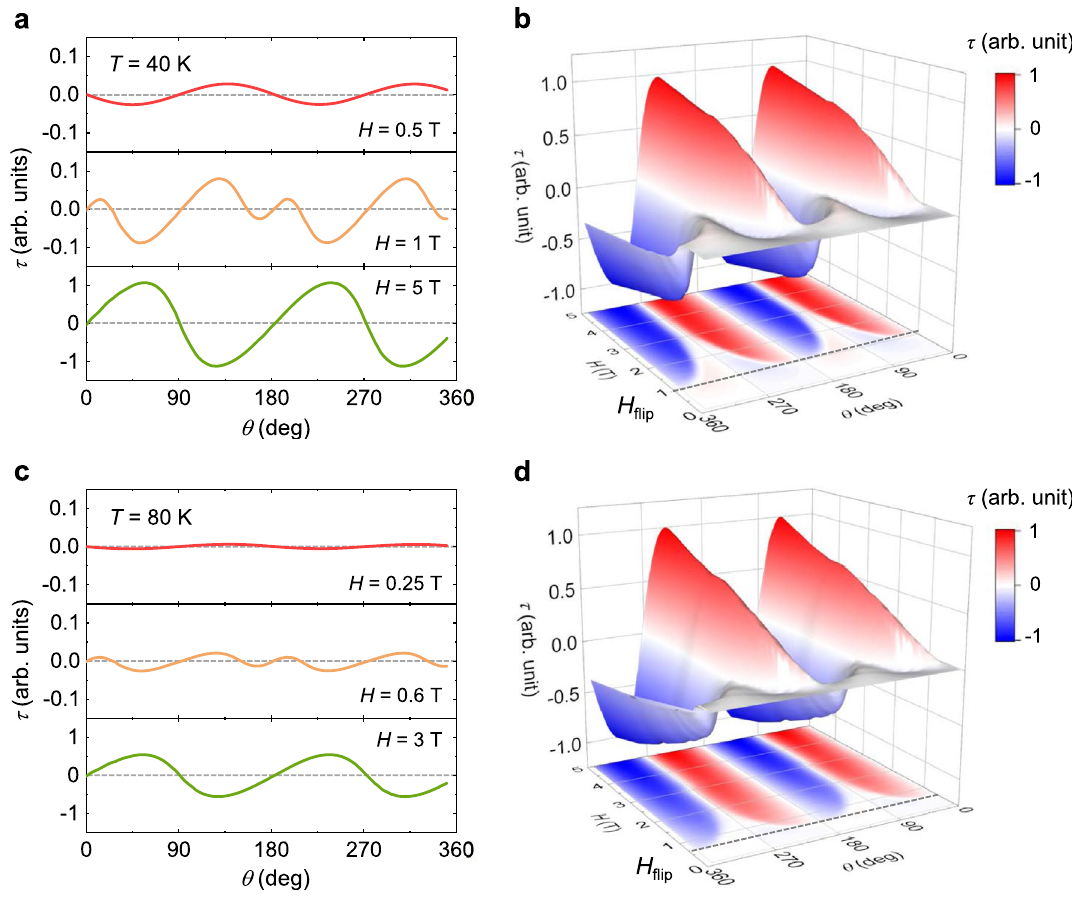
Figure 6. Temperature evolution of angle-dependent magnetic torques. ( a ) Angle dependence of the magnetic torque per unit volume, τ = M × H , measured at T = 40 K by rotating H in the ac plane at H = 0.5, 1, and 5 T. ( b ) Contour plots constructed from the angle-dependent τ data measured at various values of H and T = 40 K. The dotted line signifies the occurrence of spin-flip transition, H flip = 1.0 T ( c ) Angle dependence of τ , measured at T = 80 K by rotating H in the ac plane at H = 0.25, 0.6, and 3 T. ( d ) Contour plot for T = 80 K. The dotted line denotes the occurrence of H flip = 0.6